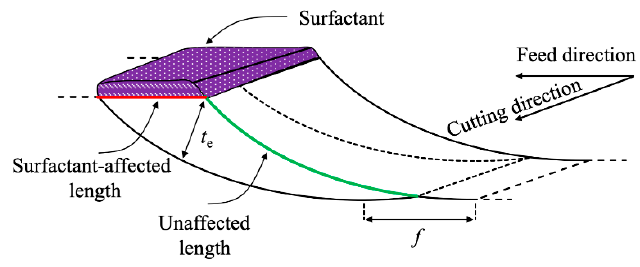
Figure 8. Geometrical relationship between the feed and the mechanochemical effect.